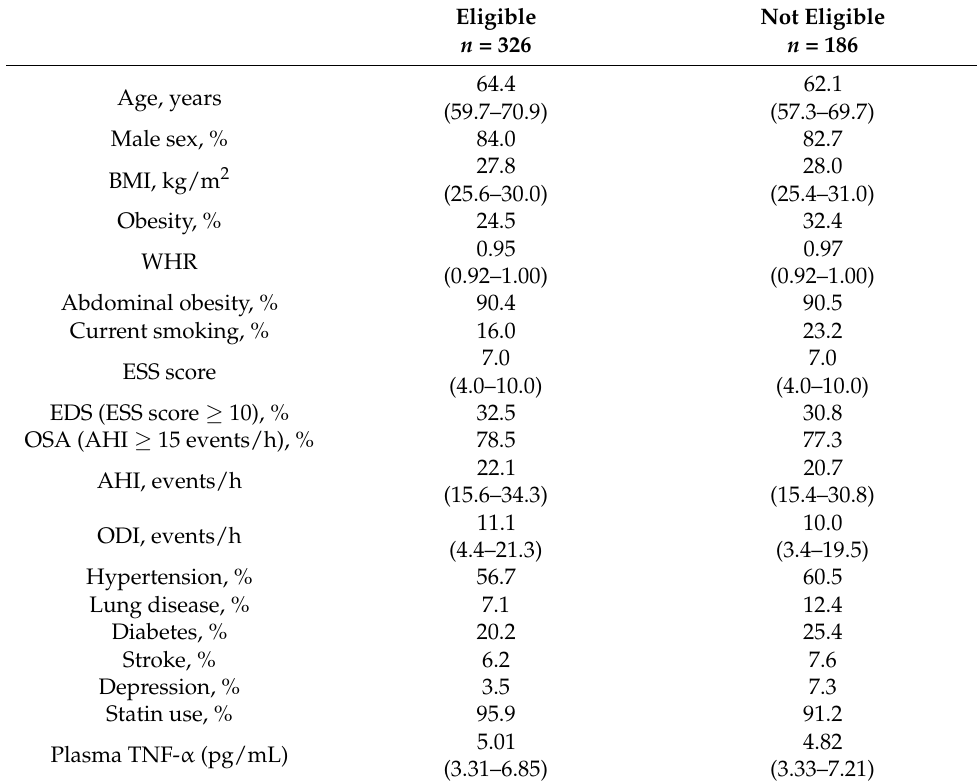
Table 1. Baseline demographic and clinical characteristics of the entire RICCADSA cohort with vs. without eligible blood samples for the genetic analysis.